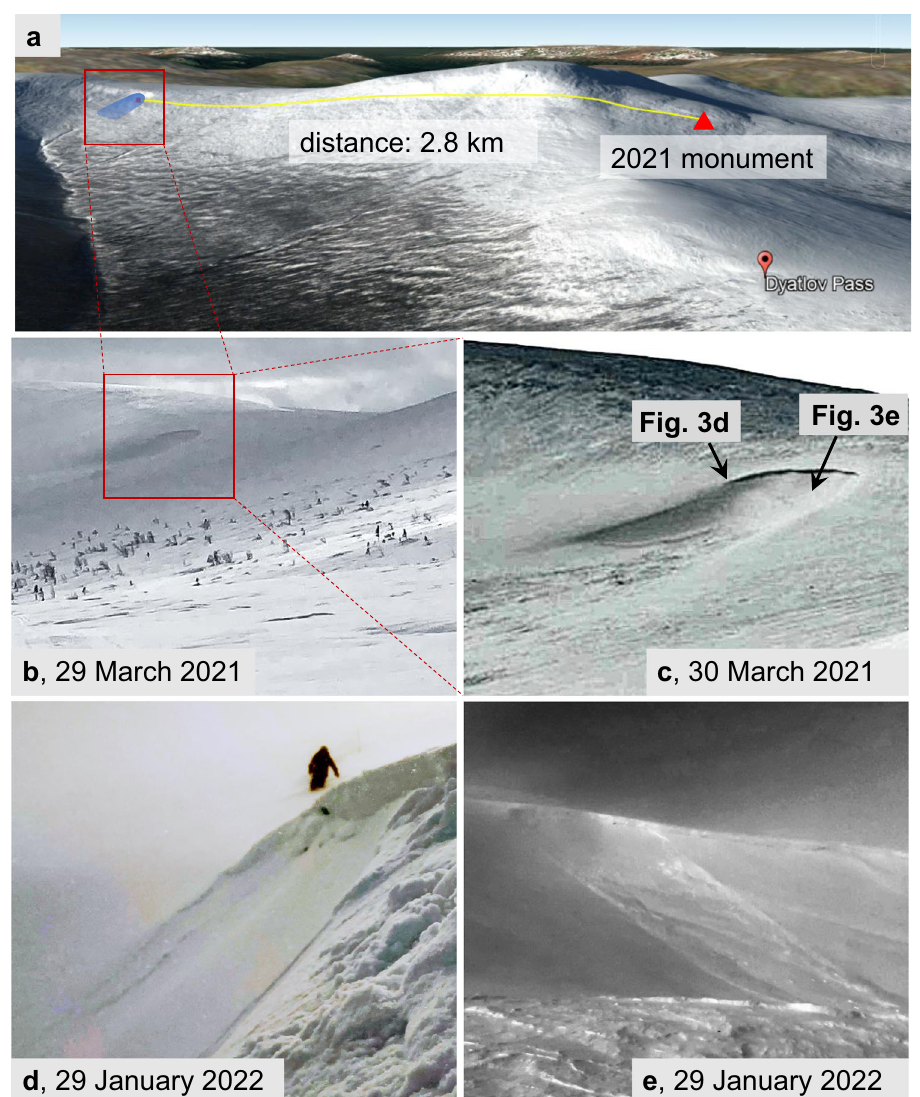
Fig. 3 Avalanches near Dyatlov Pass. a Location of the area where avalanches were observed. Source: Google Earth © 2021 Maxar technologies Landsat/ Copernicus . b Picture taken by Dmitriy Borisov on the 29th of March 2021 from the Dyatlov Pass. The zone highlighted in red is located ~3km away from the tent. c Picture extracted from a video taken by Matteo Born (RSI movie director), the day later, i.e., 30th March 2021. d Picture of a crown tensile fracture on the left side of this slope taken by Dmitriy Borisov on 29th January 2022. e Picture of a small slab avalanche in the middle of the slope by Dmitriy Borisov on the